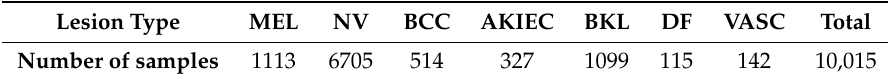
Table 1. Class Distribution of HAM10000 dataset